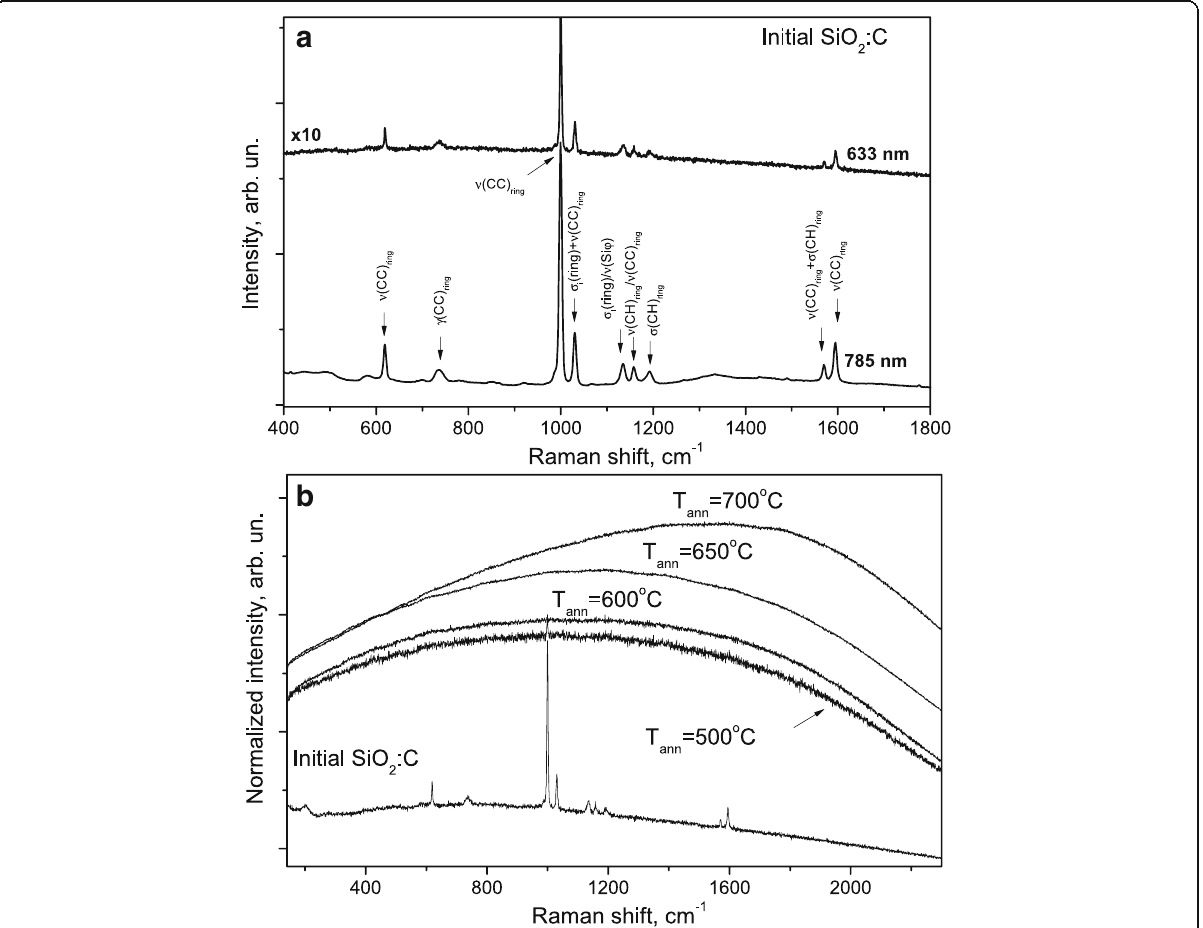
Fig. 2 The Raman spectra of the initial SiO 2 :C sample measured with different laser wavelengths ( a ) and the comparison of Raman spectra measured in the initial and annealed SiO 2 :C samples with 633 nm excitation ( b